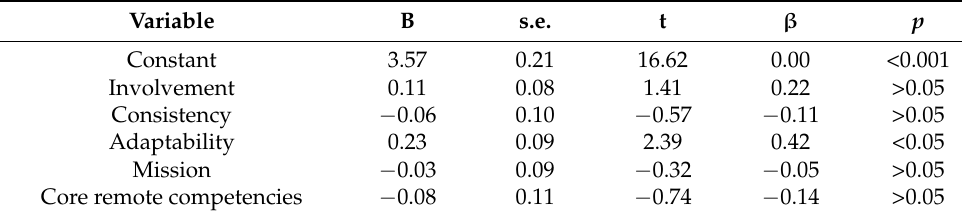
Table 6. The influence of independent variables on affective well-being. Variable B s.e. Constant